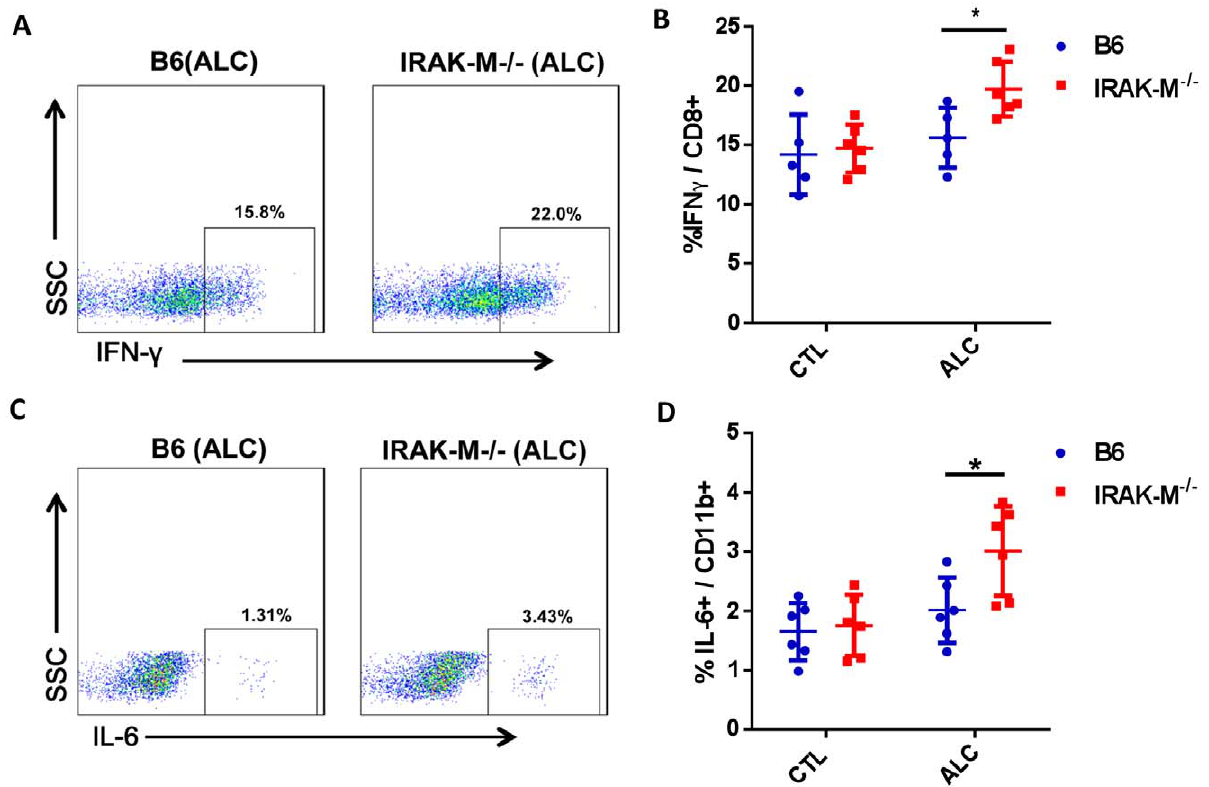
Figure 4. Inflammatory cytokine in LMNCs. Ex vivo LMNCs were stained with intracellular cytokines and different surface markers as described in Materials and Methods . (A) Representative FACS plots showing IFN c + cells after gating CD8 + T cells in alcohol treated mice. (B) Summary of percentage of IFN c producing CD8 T cells in LMNCs of control (CTL) and alcohol treated (ALC) B6 (blue) and IRAK-M 2 / 2 mice (red). (C) Representative FACS plots showing IL-6 producing CD11b + Kupffer cells after gating CD11b + LMNCs in alcohol treated mice. (D) Summary of percentage of IL-6 producing CD11b + Kupffer cells in LMNCs of control (CTL) and alcohol treated (ALC) B6 (blue) and IRAK-M 2 / 2 mice (red). Error bars represent the SD of samples within a group. Experiments were performed 4 times and n=2–4 in each group of each experiment. The data presented are from two pooled experiments. * P , 0.05, (Two-way ANOVA test).